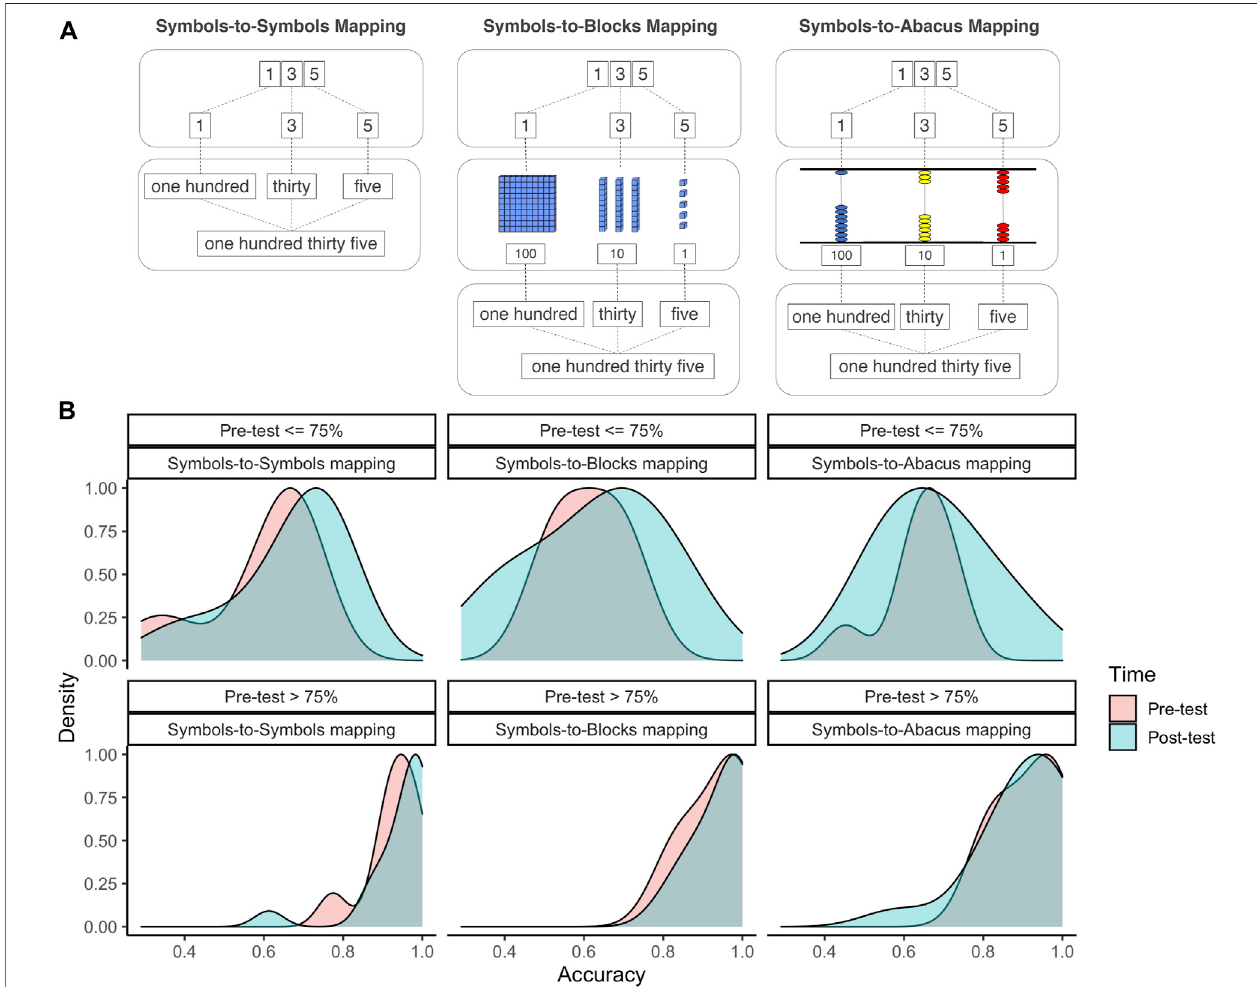
FIGURE 3 | (A) : Illustrations for the three mapping conditions in Experiment 1. (B) : Density graphs ofparticipants ’ accuracy in Experiment 1 by condition, test time (pre- and post-test), and pre-test familiarity with multi-digit number symbols. In (B) top row: children who scored less than or equal to 75% at pre-test. In (B) bottom row: children who scored above 75% at pre-test. Pink indicates pre-test performance and turquoise indicates post-test performance.